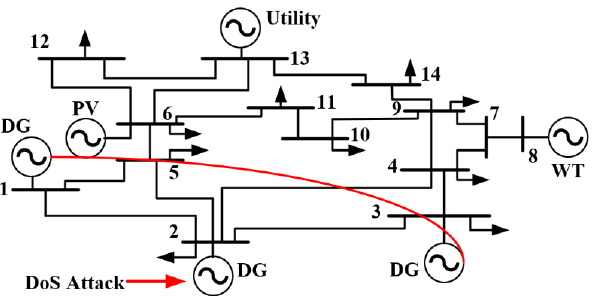
Figure 15. Rearranging communication links between Distributed DGs during the DoS/DDoS attack.